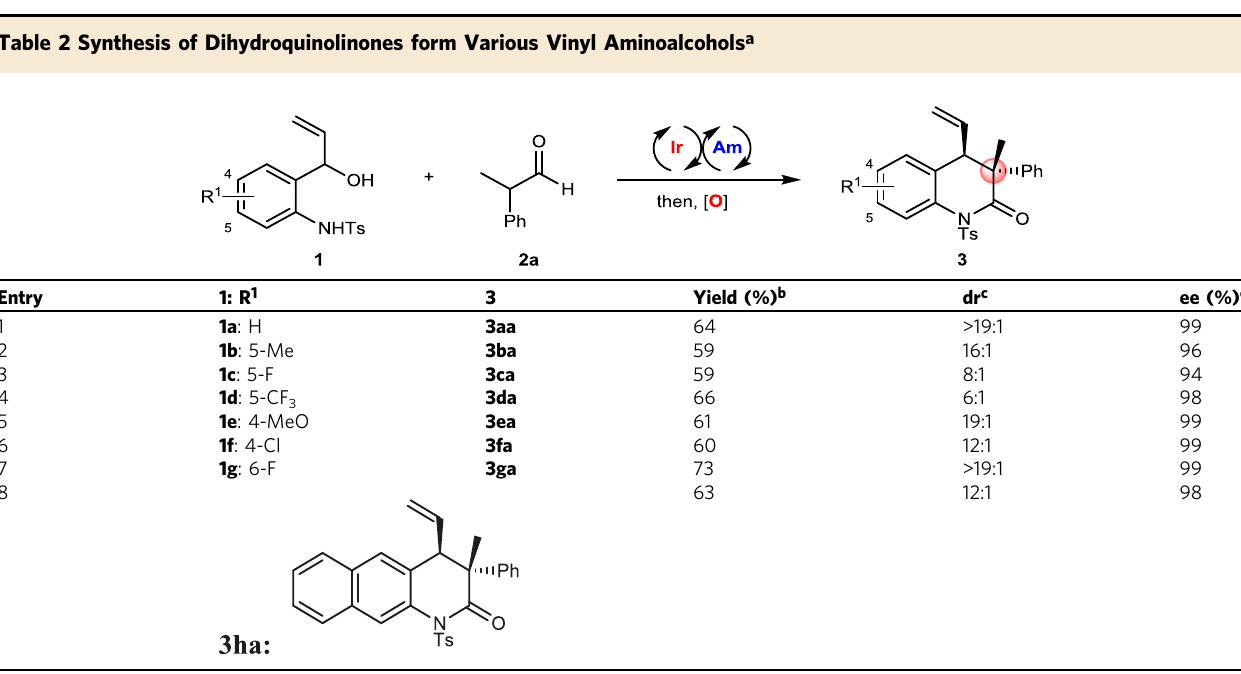
Table 2 Synthesis of Dihydroquinolinones form Various Vinyl Aminoalcohols